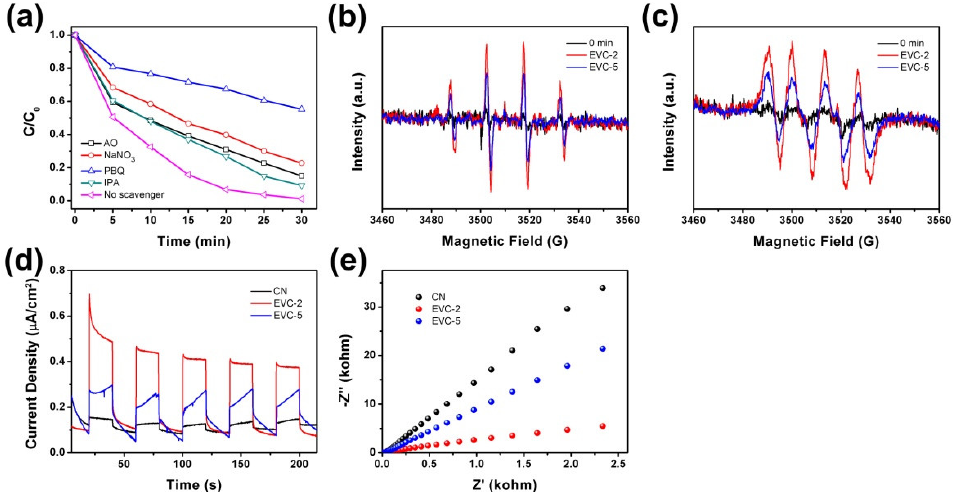
Figure 10. ( a ) the effect of radical scavengers on MB photocatalytic degradation on EVC-2 under 40 W LED irradiation: the ESR spectra of ( b ) DMPO- • OH in water; ( c ) DMPO- • O 2 − in methanol with EVC-2 and EVC-5 after 15 min of visible light irradiation; ( d ) TPC spectra; ( e ) EIS Nyquist plots of CN, EVC-2, and